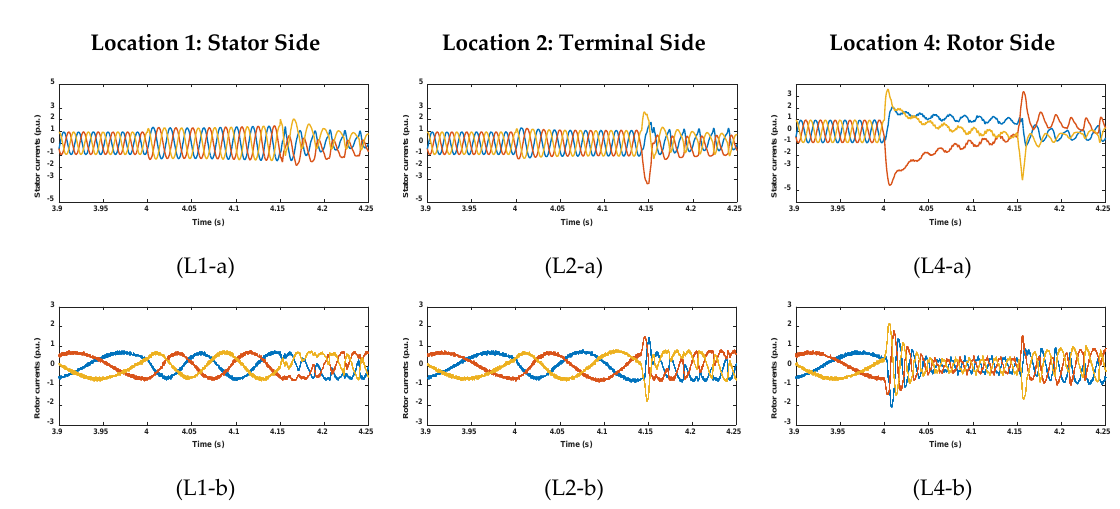
Figure 13. With the resistive type fault current limiter in the stator side (L1), in the terminal side (L2), and in the rotor side (L4) during a three-phase fault: ( a ) The stator currents; and ( b ) the rotor currents.